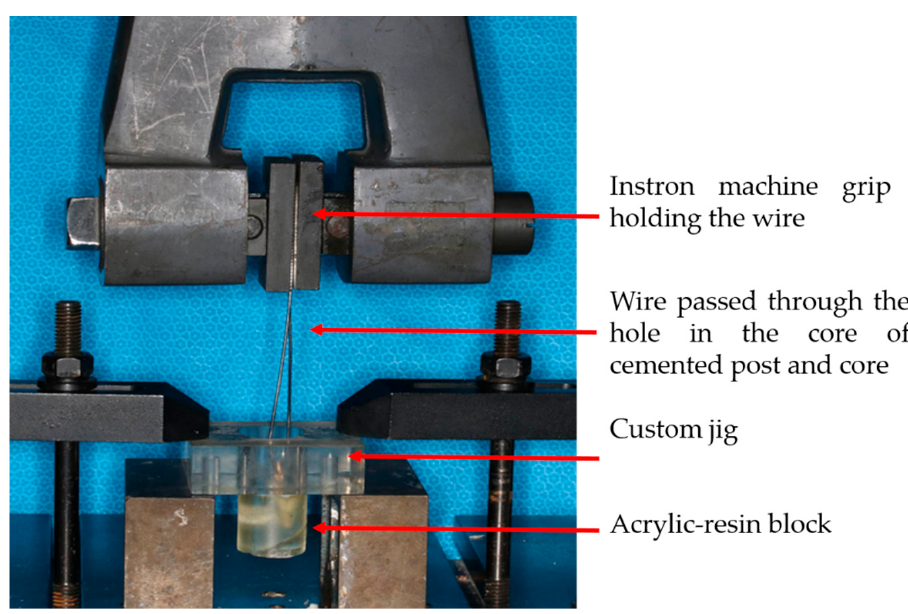
Figure 7. Specimen of mounted post and core in testing assembly for retention test.